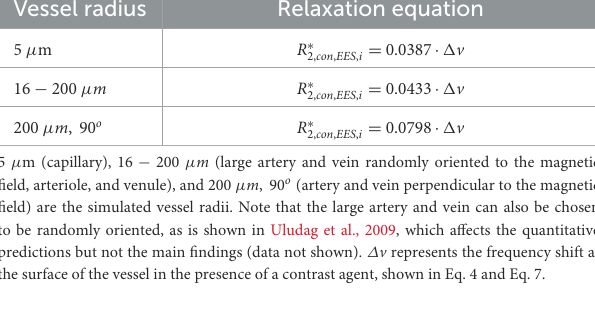
TABLE 2 Summary of simulated voxel properties for arterial, tissue, and venous